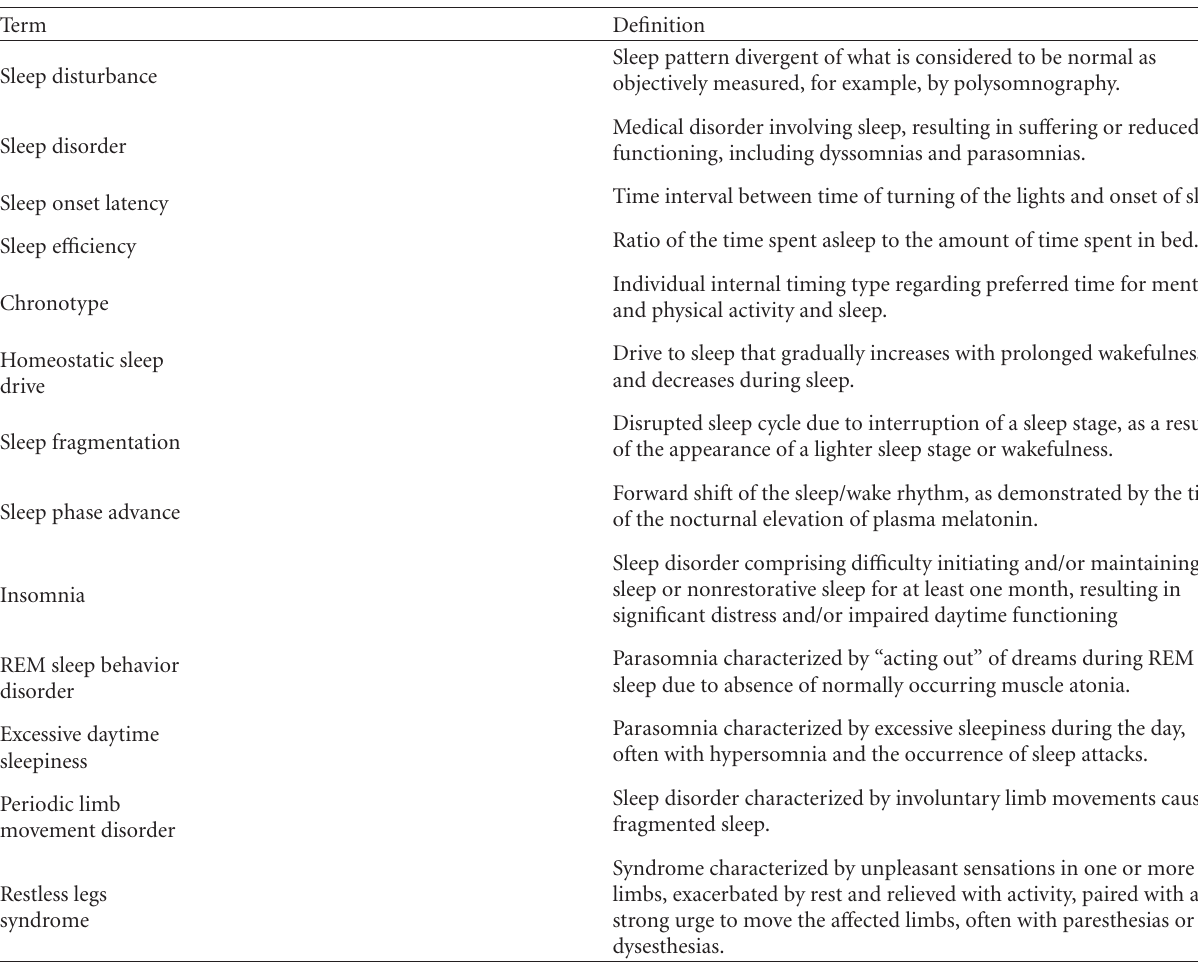
Table 1: Definitions of sleep